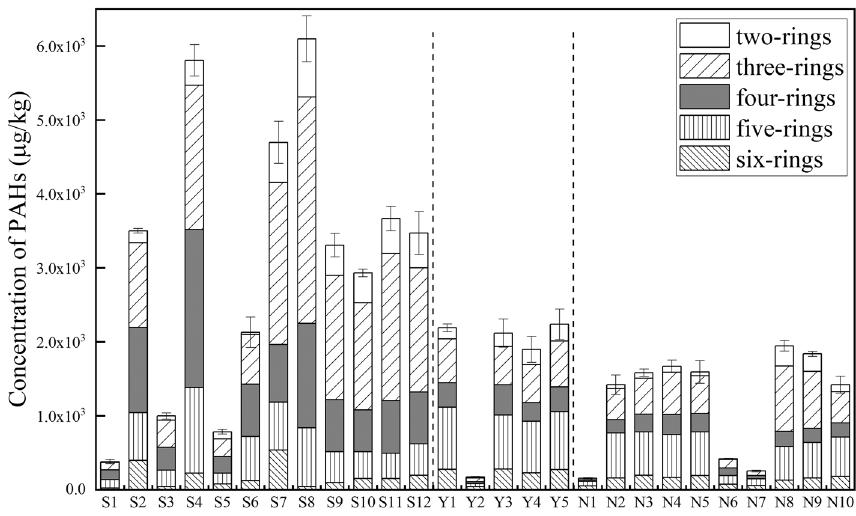
Figure 5. The concentration of PAHs in three different geographic oilfield